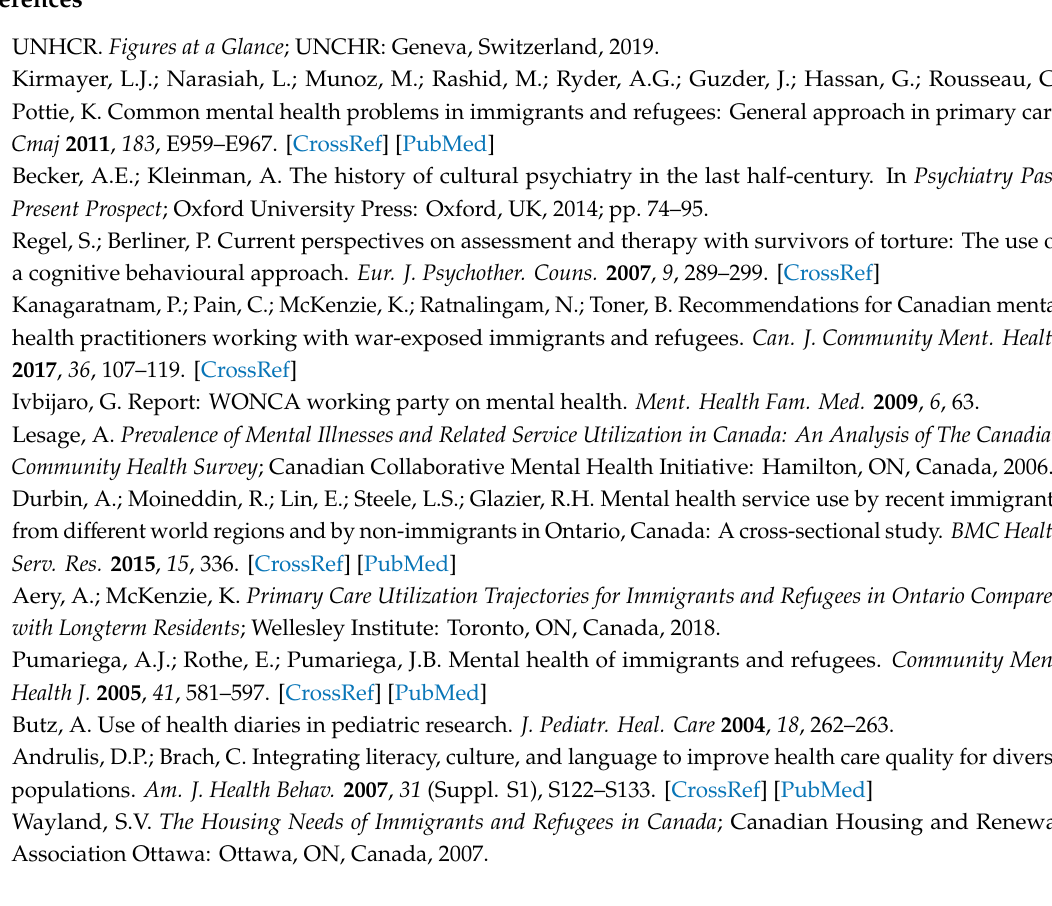
Table S1, RAMESES Publication Standards: Realist Synthesis; Table S2, Inclusion and exclusion criteria; Table S3, Search strategy; File S4, Critical appraisal; Table S5, E ff ectiveness of psychotherapies; Table S6, Key elements and provider